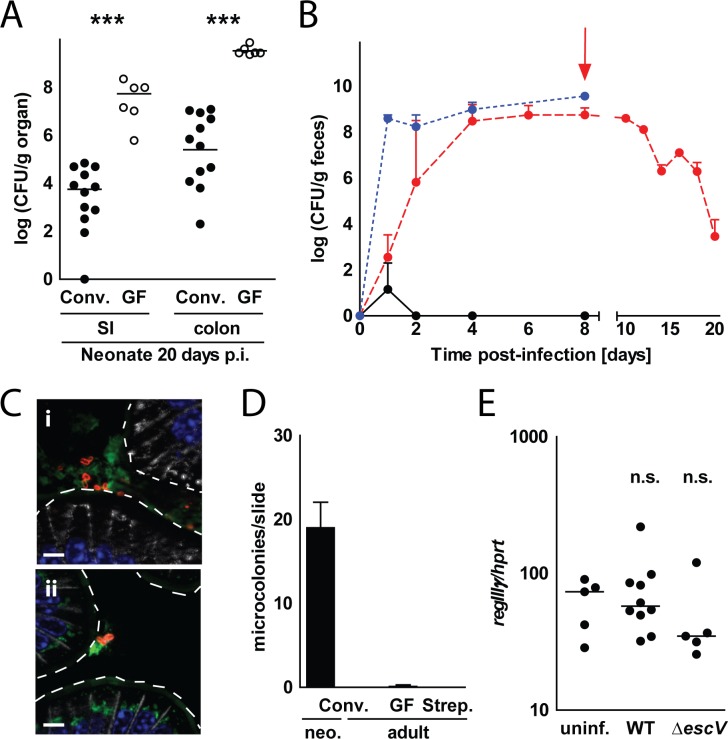
The influence of the enteric microbiota and intestinal development on colonization and microcolony formation.
(A) 1-day-old conventional (conv.) and germ-free (GF) mice were orally infected with WT EPEC. Small intestinal and colon tissues were collected 20 days p.i., homogenized and plated on LB agar plates supplemented with the appropriate antibiotic (n = 6–12 from 1 litter for GF mice and 5 litters for conventional mice; median). (B) Conventional adult mice treated with streptomycin in drinking water (red dotted line) or left untreated (black line) as well as untreated adult germ-free mice (blue dotted line) were infected with WT EPEC. Streptomycin treatment was stopped 8 days p.i. (red arrow). Feces were collected at the indicated time point p.i., homogenized and plated on LB agar plates supplemented with the appropriate antibiotic (n = 3–33; median ± interquartile range). (C) Immunostaining of small intestinal tissue sections collected 8 days p.i. from adult streptomycin-treated (i) and germ-free mice (ii) orally infected with WT EPEC (EPEC, red; E-cadherin, white; wheat germ agglutinin (mucus), green; DAPI, blue; bar = 5μm). (D) Number of microcolonies observed per small intestinal tissue section of 1-day-old and non-treated, streptomycin-treated and GF adult animals infected with WT EPEC 8 days p.i. (n = 9 from 3 mice per time point, mean ± SD). (E) IEC were isolated from the small intestines of adult streptomycin-treated, WT EPEC or escV mutant-infected animals at 8 days p.i. and the expression level of RegIIIγ was measured and normalized to the values obtained for hprt (n = 5–10; median). Student’s t-test (A) and Kruskal-Wallis ANOVA with Dunn’s multiple comparison post-test (E). ns, p>0.05; ***, p<0.001.